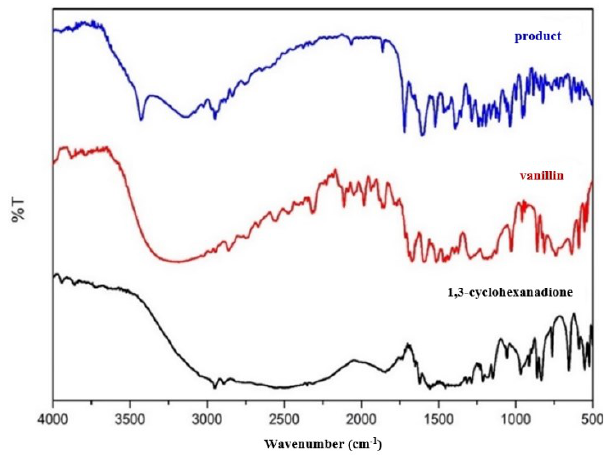
Table 2. Synthesis Results Fig. 3. The FTIR Spectrum of the Product and Reactant The synthesized product's structure identification was completed through FTIR analysis to identify the compound's function group. The IR spectrum of Compound 1 presented six particular absorption bands, as shown in Figure 3. The first band had a strong and wide intensity at 3313.71 cm -1 wave number, indicating the O-H bond stretching vibration. The second absorption band showed medium and sharp intensity at 2953.02 cm -1 wavenumber, representing the aliphatic C-H bond stretching vibration. Meanwhile, the third absorption band showed robust and sharp intensity at 1662.21 cm -1 wavenumber, signifying the C=O bond stretching vibration. The fourth band showed strong and sharp intensity at a wavenumber of 1620.21 cm -1 , suggesting C=C aliphatic bond stretching vibration. The fifth band had robust and sharp intensity at a wavenumber of 1512.19 cm -1 , indicating the C=C aromatic bond stretching vibration existence. Lastly, the sixth absorption band had strong and sharp intensity at 1274.95 cm -1 wavenumber, signifying the C-O stretching vibration. The IR analysis results are in accordance with the study conducted by Dos Santos et al. [11]. The formation of the product was also indicated by the disappearance of the signal at wave number 1714 cm -1 in the IR spectra of the product, representing the carbonyl aldehyde signal on vanillin. Also, the appearance of a signal at wave number 1662.61 cm -1 represented a carbonyl ketone signal, followed by the appearance of a signal at wave number 1620.21 cm -1 , which represented a C=C aliphatic bond. The appearance of a signal at wave number 3313.71 cm -1 representing the -OH bond in the IR spectrum of the